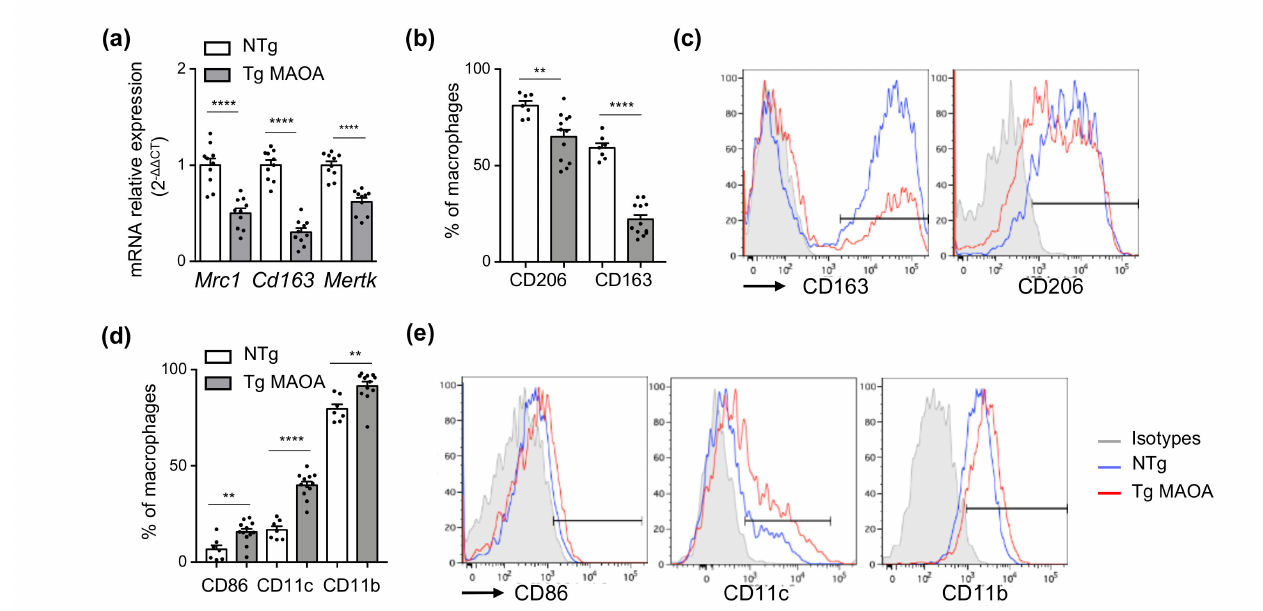
Figure 5. Cardiac macrophages of Tg MAOA mice have decreased expression of phagocytic receptors. ( a ) Relative mRNA expression of phagocytic receptors by cardiac macrophages of Tg MAOA compared to NTg mice ( n = 10 mice per group). ( b – e ) Flow cytometry analysis of cardiac macrophages from NTg ( n = 7) and Tg MAOA ( n = 12) mice for M2 ( b , c ) and M1 ( d , e ) marker expression. Percentages of positive cells ( b , d ) and representative histograms ( c , e ) are shown. ( e ) Data are expressed as means ± SEM. ** p < 0.01, **** p < 0.0001 vs. NTg